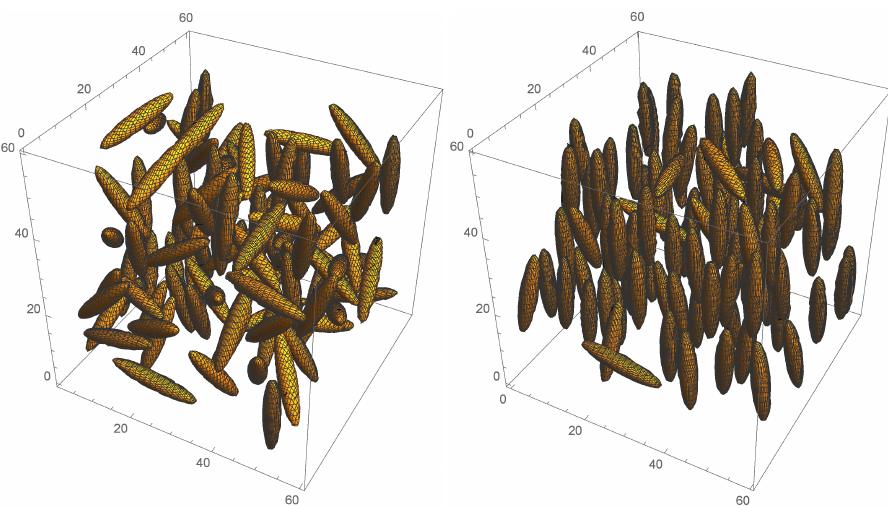
Figure 2. Visualisation of the CNT-filled composite with k = 1 and k = 10.